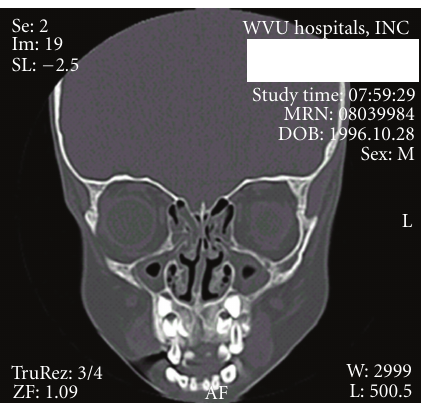
Figure 3: Coronal CT scan of the sinuses demonstrating significant disease in both ethmoids and maxillary sinuses with blockage of the